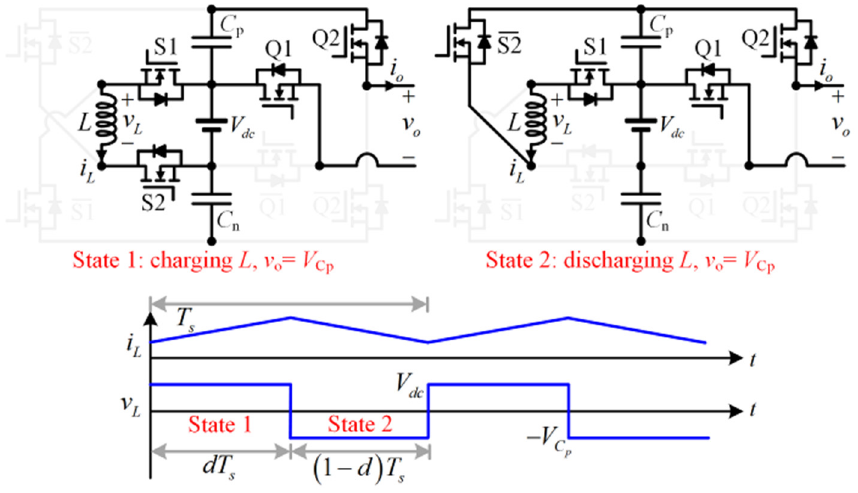
Figure 2. Switching states and key waveforms of the universal converter operating in mode 1 for generating a positive dc